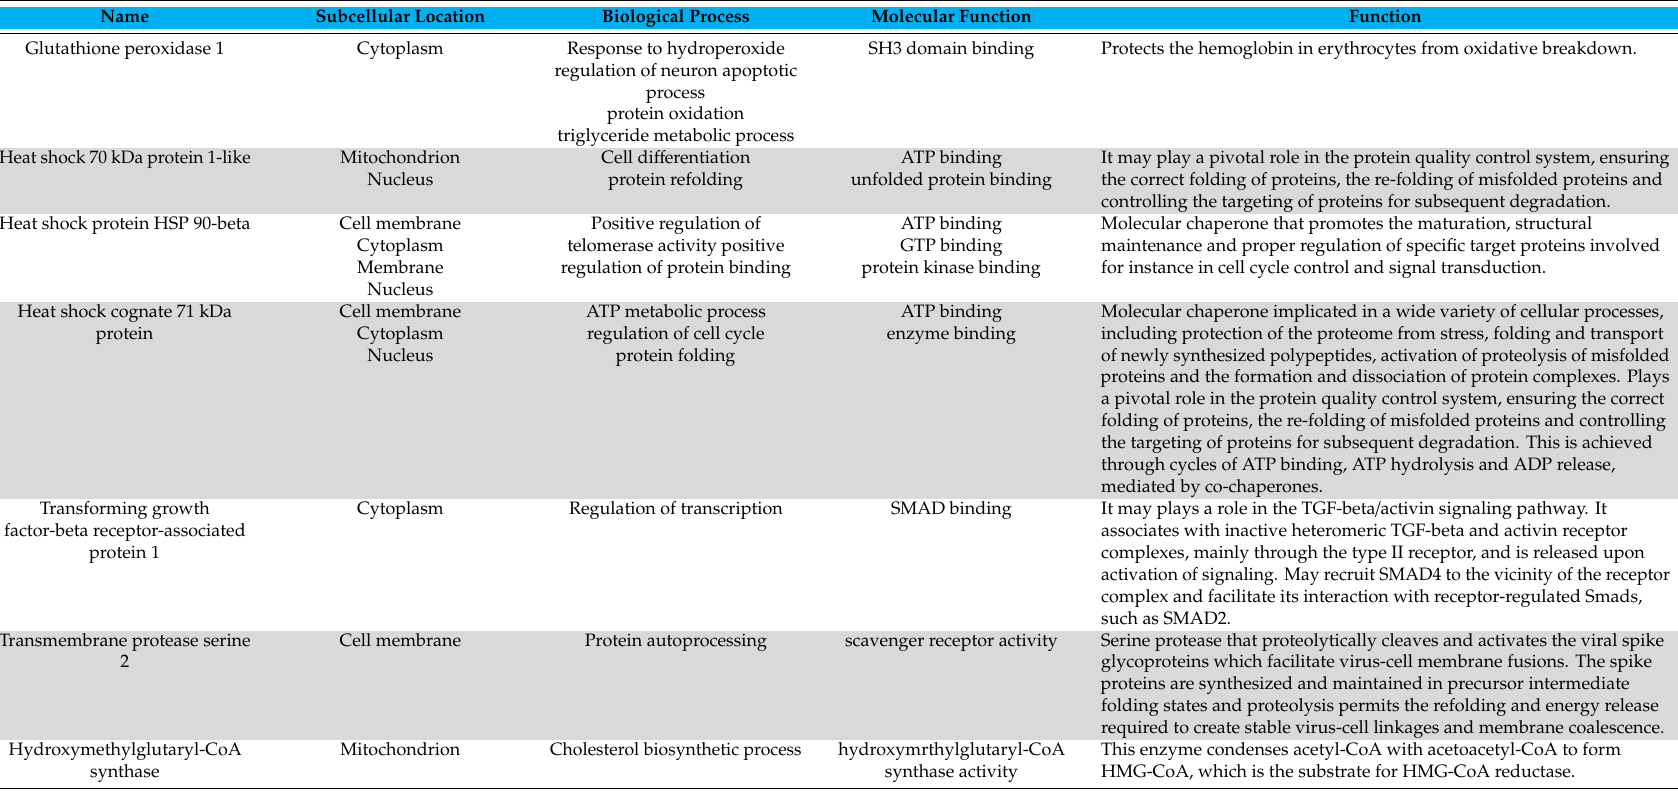
Table 6. Summary of protein function corresponding to